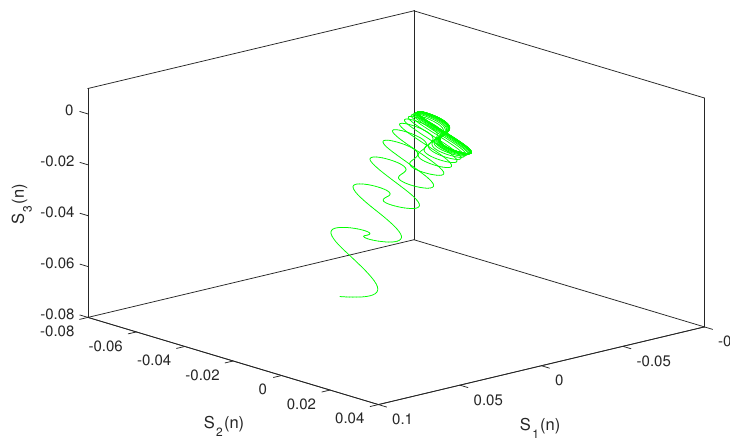
Figure 10. Discrete situation T = Z : S 1 ( n ) , S 2 ( n ) , S 3 ( n )